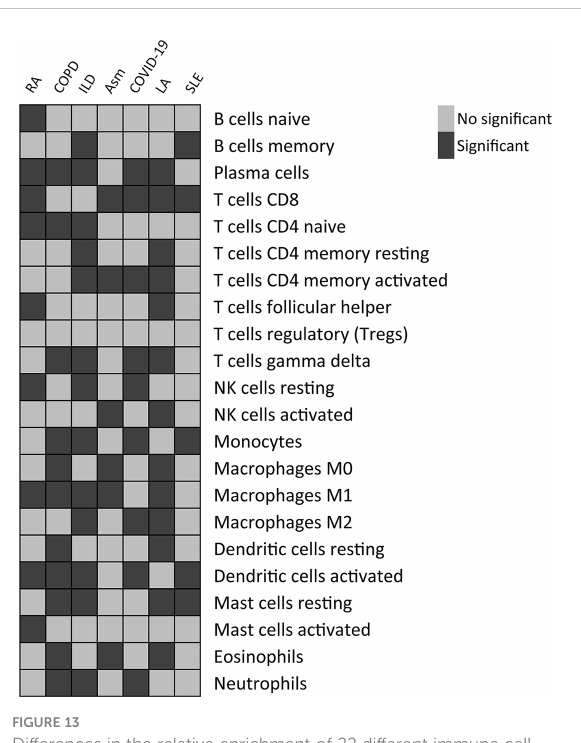
FIGURE 13 Differences in the relative enrichment of 22 different immune cell subtypes in TB-related disease